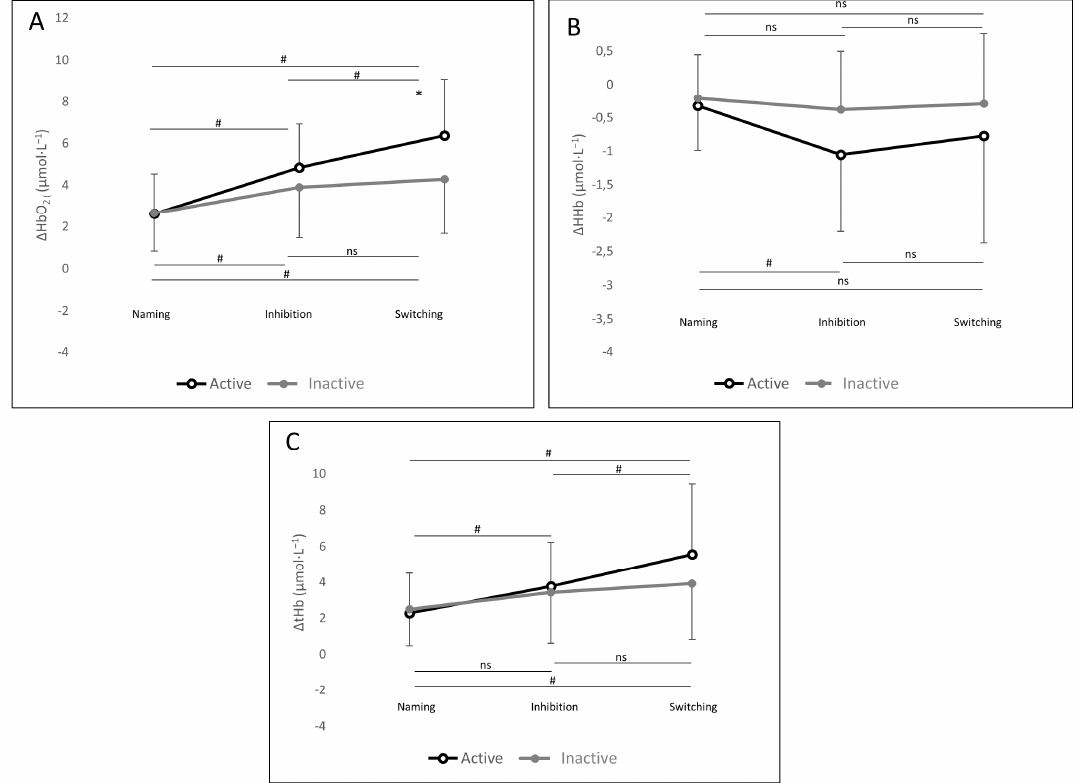
Figure 2. Total cerebral oxygenation (both hemispheres of prefrontal cortex (PFC)) during Computerized Stroop task conditions. ( A ) Change in total oxyhemoglobin ( ∆ HbO 2 ), ( B ) Change in total deoxyhemoglobin ( ∆ HHb), ( C ) Change in total total hemoglobin ( ∆ tHb). Data are presented as means and SDs; * p < 0.05 between active and inactive group. # p < 0.05 between Stroop conditions.